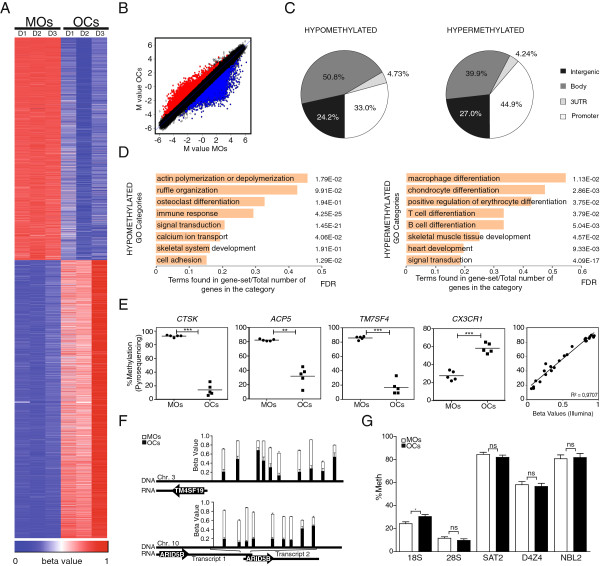
High-throughput methylation comparison between monocytes (MOs) and derived osteoclasts (OCs). (A) Heatmap including the data for three paired samples of MOs (MO D1, D2, D3) and their derived OCs (OC D1, D2, D3) harvested on day 21. The heatmap includes all CpG-containing probes displaying significant methylation changes (8,028 in total with FC ≥2 or FC ≤0.5; P ≤0.01 and FDR ≤0.05) (Additional file 2). Scale shown at the bottom, whereby beta values (that is, the ratio of the methylated probe intensity to the overall intensity, where overall intensity is the sum of methylated and unmethylated probe intensities) ranging from 0 (unmethylated, blue) to 1 (completely methylated, red). (B) Scatterplot showing the mean methylation profile of three matching MO/OC pairs. Genes with significant differences (FC >2, FDR <0.05) in averaged results from the three pairs of samples are highlighted in red (hypermethylated) or blue (hypomethylated). (C) Distribution of differentially methylated CpGs among genomic regions (promoter, gene bodies, 3′UTR, and intergenic) in different subsets of CpGs (hypomethylated, hypermethylated). (D) Gene ontology enrichment analysis of hypomethylated and hypermethylated CpGs showing the most important categories. (E) Technical validation of the array data by bisulfite pyrosequencing of modified DNA. BS pyrosequencing of three representative hypomethylated genes (ACP5, CTSK, and TM7SF4) and one hypermethylated gene (CX3CR1) from the array data are shown. A representation showing the excellent correlation between array data (beta values) and pyrosequencing data (% methylation) including the data for the four genes (right panel). (F) Cluster analysis of contiguous differentially methylated regions (<500 bp). Two examples of regions with more than nine consecutive CpGs differentially methylated are shown. (G) Analysis of methylation levels in repetitive elements (Sat2, D4Z4, NBL2) and ribosomal RNA genes (18S and 28S regions) as obtained from bisulfite sequencing analysis.